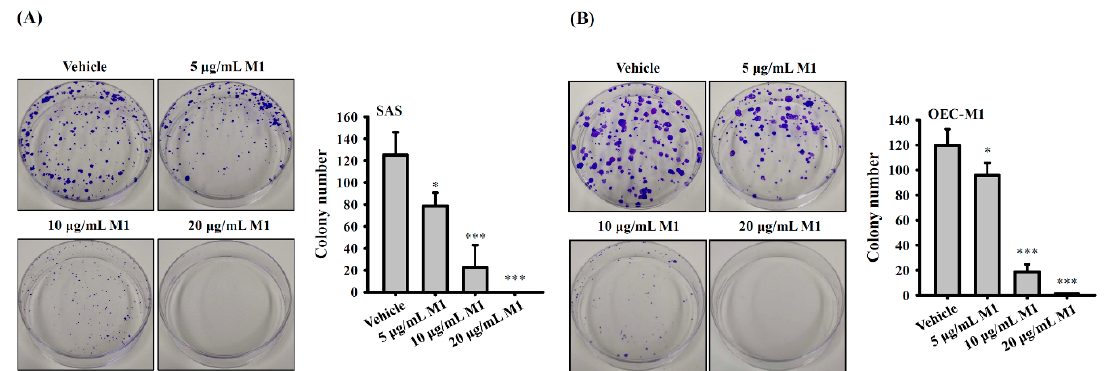
Figure 6. Ginsenoside M1 reduced colony formation ability of human oral cancer cells. SAS cells ( A ) or OEC-M1 cells ( B ) were incubated for 10 days with ginsenoside M1 or vehicle. The colony numbers were analyzed by crystal violet staining. The data were expressed as mean ± SD; n = 4. * and *** indicate a significant di ff erence at the level of p < 0.05 and p < 0.001, respectively, compared to vehicle-control cells. (One-way ANOVA with Dunnett’s multiple comparisons test).